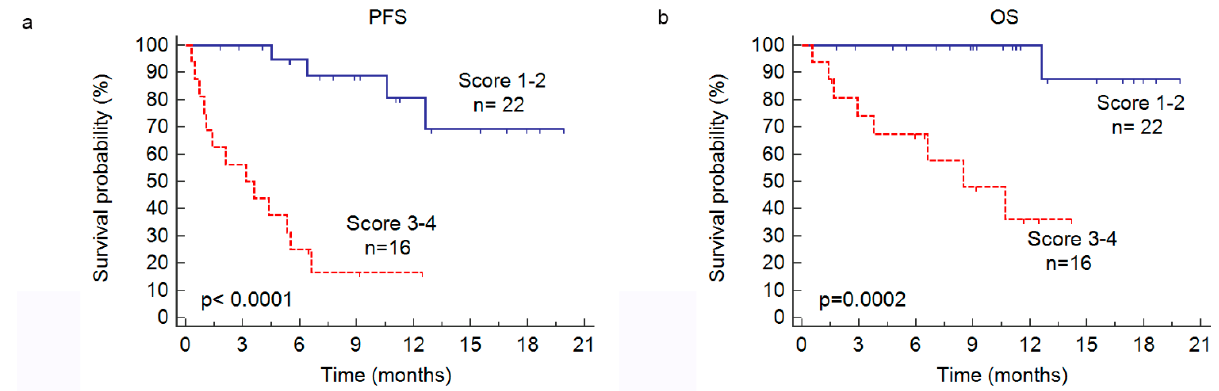
Figure 2. Kaplan–Meier estimates of progression-free survival (PFS, a ) and overall survival (OS, b ) in accordance with a prognostic score of 1–2 versus 3–4 points, which was a combination of the initial ISS score (1,2 or 3 points) with the presence of more than three focal lesions detected on PET (>3 FL: 1 point) or less than/equal to three FLs ( ≤ 3 FLs, 0 points).